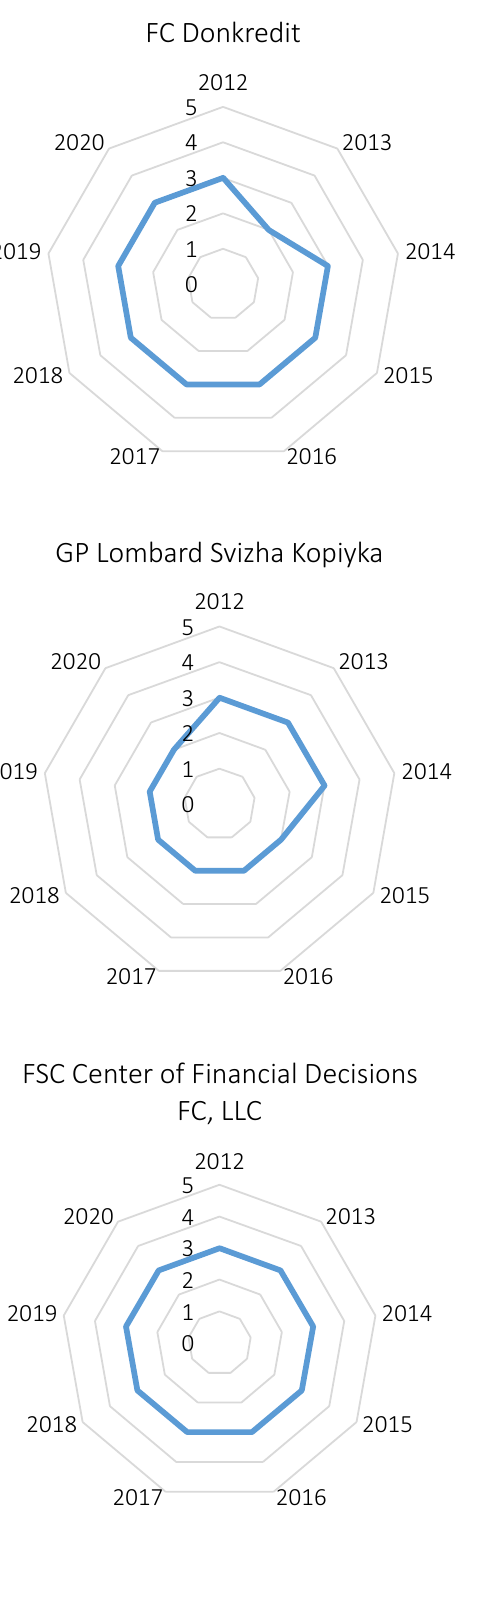
Figure A1 (cont.). Development patterns of financial intermediaries’